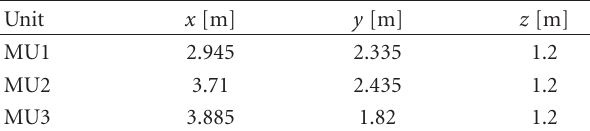
Table 4: Positions of the mobile units in E2.